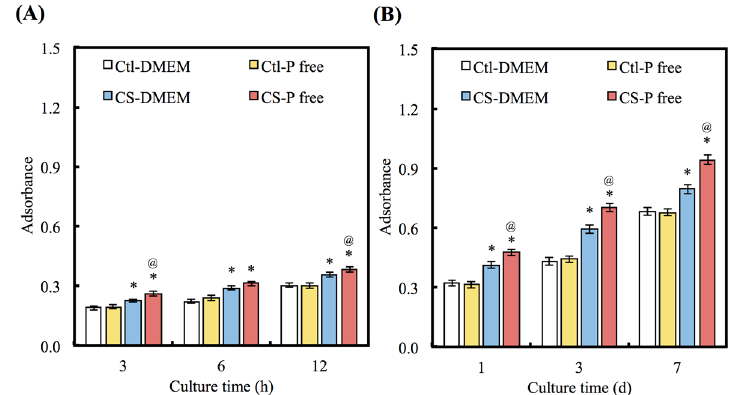
Figure 5. ( A ) The adhesion and ( B ) proliferation of hDPCs cultured with various DMEM for different time points. “*” indicates a significant difference ( p < 0.05) compared to same material with DMEM. “@” indicates a significant difference ( p < 0.05) compared to Ctl in same medium.